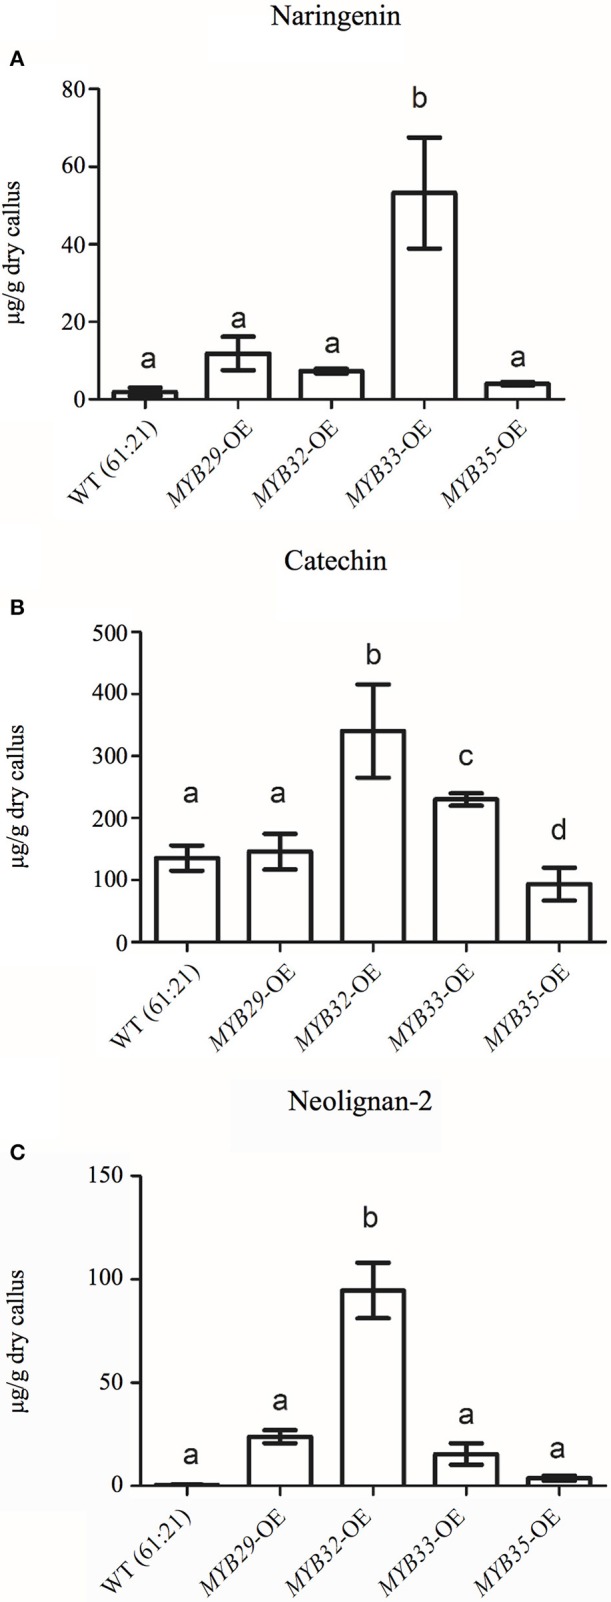
Average naringenin (A), catechin (B), and neolignan-2 (C) contents in μg/g of dry callus for WT (p < 0.05) and the transformant lines overexpressing MYB29, MYB32, MYB33, and MYB35 (n = 3). Letters indicate statistical differences (p > 0.05) in a one-way ANOVA with Dunns post-test (P < 0.05).